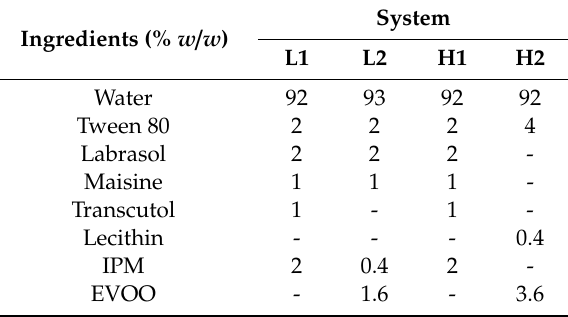
Table 1. Composition of the